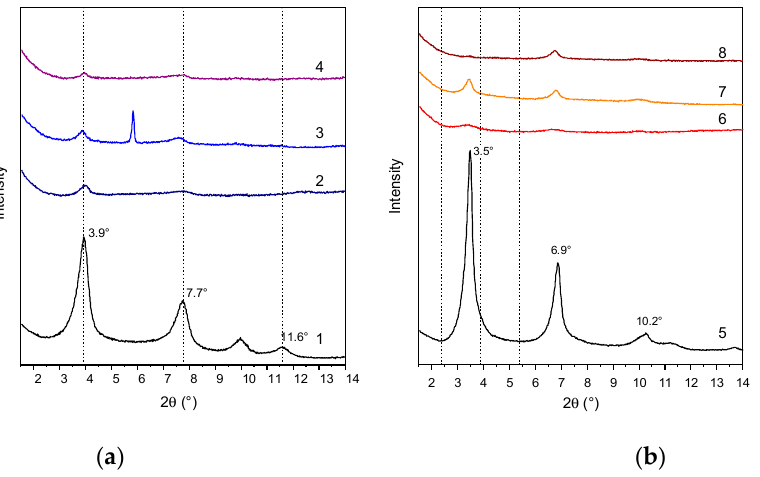
Figure 4. XRD patterns of LDH-RA (1), PLA/LDH-RA (2), PBS/LDH-RA (3), and PLA/PBS/LDH-RA (4) ( a ) and LDH-DS/RA (5), PLA/LDH-DS/RA (6), PBS/LDH-DS/RA (7), and PLA/PBS/LDH-DS/RA (8) ( b ). The signal at 5.8° (2 θ ) in the XRD pattern of PBS/LDH-RA (3) is due to the presence of impurity.